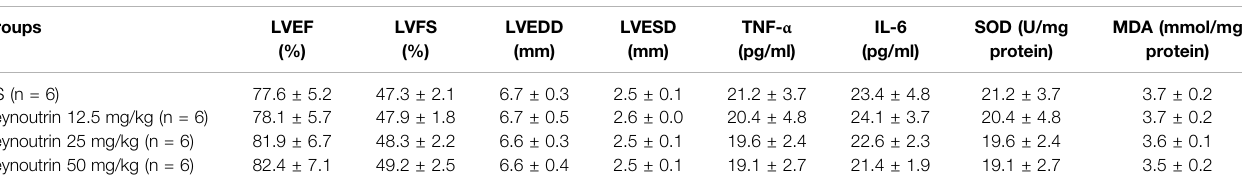
TABLE 1 | The effects of reynoutrin on normal rats (means ± S.E.M).